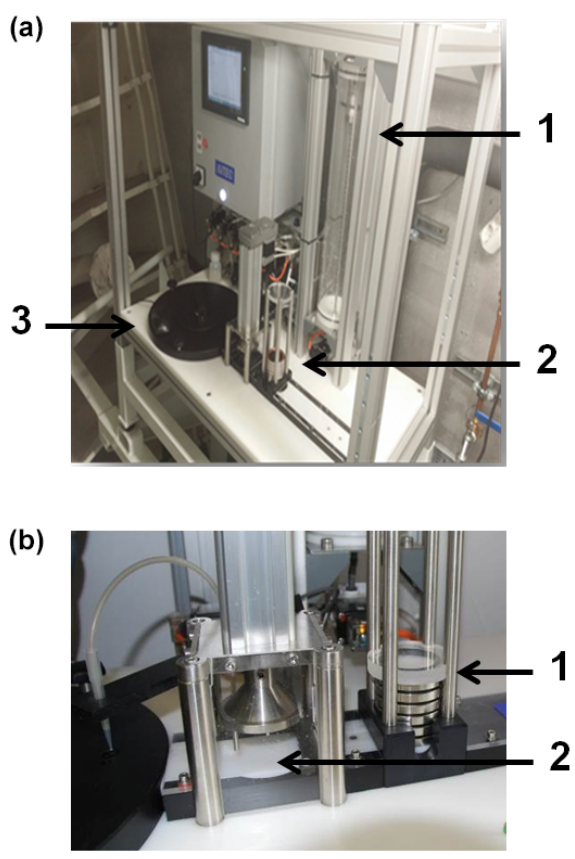
Figure 2. (a) AUTOFIM installed on board RV Polarstern (1: Sam- ple reservoir; 2: Filtration; 3: Archive for preserved filters). (b) Filtration-module (1: Filter stacker; 2: Filtration